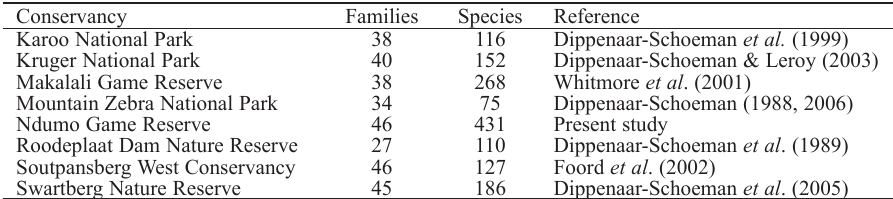
Table 3 Currently known total species diversity of spiders (Araneae) recorded from South African